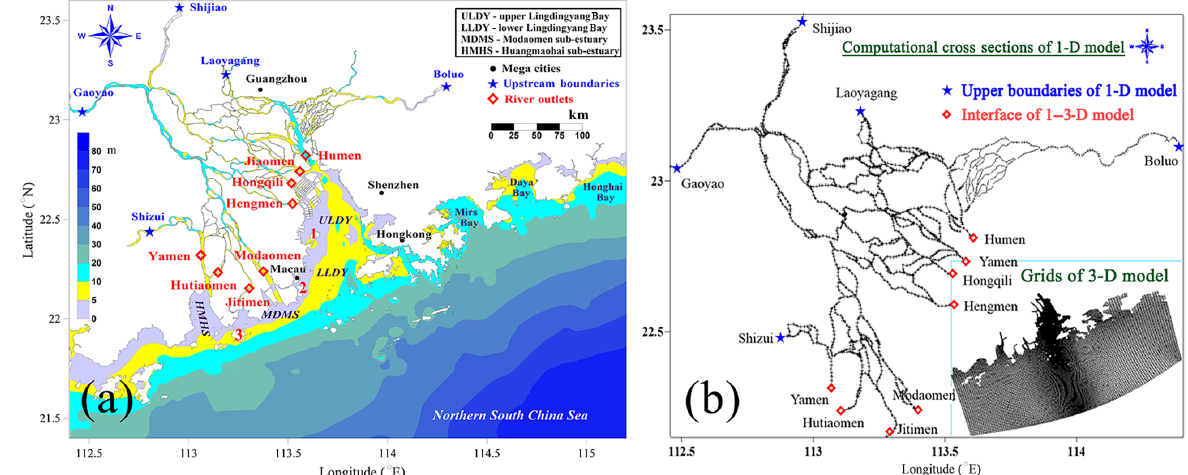
Figure 1. Maps showing (a) the Pearl River Delta with the Pearl River network and the Pearl River estuary (PRE) and (b) computational cross sections for the 1-D model and model grids for the 3-D model. The red numbers in (a) represent islands which are not marked on the map: 1 – Qi’ao island; 2 – Hengqin Island; 3 – Gaolan